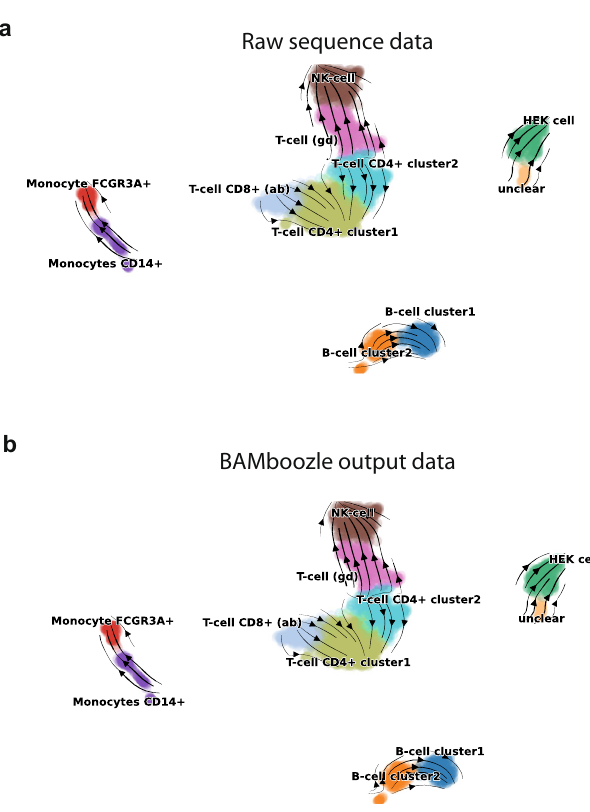
Fig. 4 Genotype-free RNA-seq data maintains splicing kinetics information. a RNA velocity inferred from raw single-cell RNA-sequence data, with estimated cellular fl ows overlaid on top of the UMAP visualization ( b ). b RNA velocity analysis of single-cell RNA-sequencing data after removal of genetic variation with BAMboozle show similar cell- state fl ows as in the analysis run on raw sequence data ( a